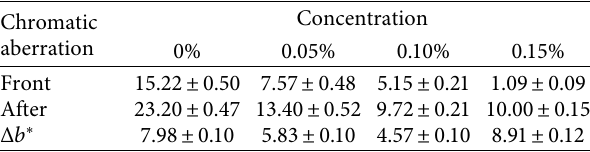
Table 3: b ∗ value and difference before and after the aging of silicone rubber specimens coated with nano-TiO 2 with different concentrations of silicon and aluminum ( F � 1951.636, P < 0 . 05).